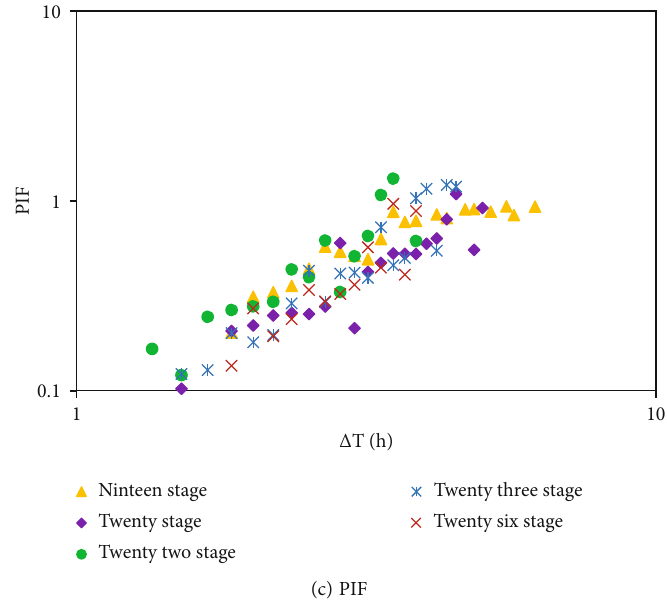
Figure 7: The Δ P , Δ P ′ , and PIF for each stage. Well LCG-5 is interfered with when well LCG-4 is fractured at stages 19, 20, 22, 23, and